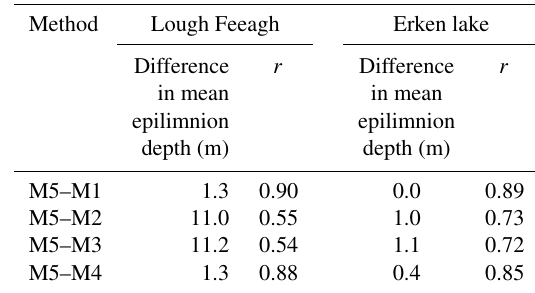
Table 5. Difference in mean April–October epilimnion depth esti- mates (m) between each profile-based method (M1–M4) calculated using lake modelled data and the modelled turbulence method (M5) and mean of all Pearson’s correlation coefficients ( r ) calculated for each profile-based method and M5 (e.g. for all threshold combi- nations between M5 and M1) for Lough Feeagh and Erken lake. Positive differences indicate that the modelled turbulence method is